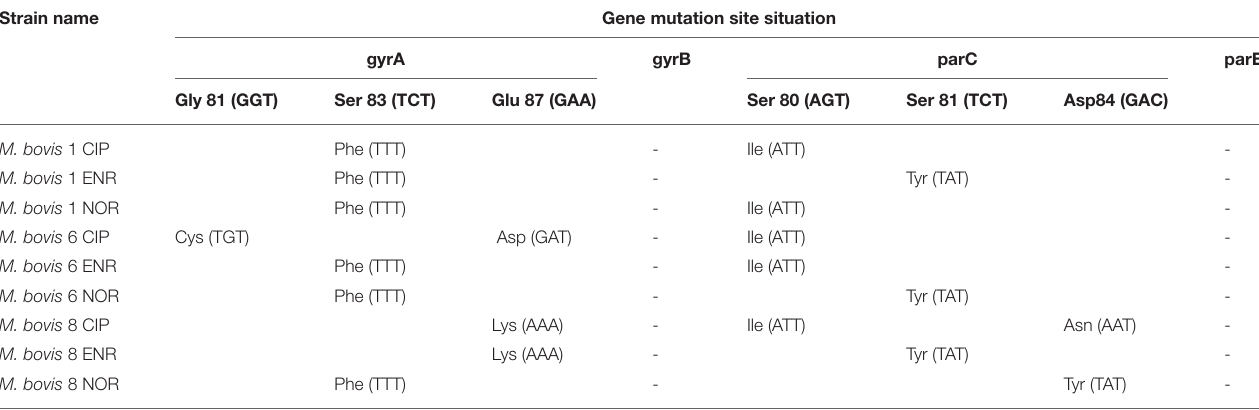
TABLE 5 | The QRDR mutations of strains induced in vitro to fluoroquinolones.